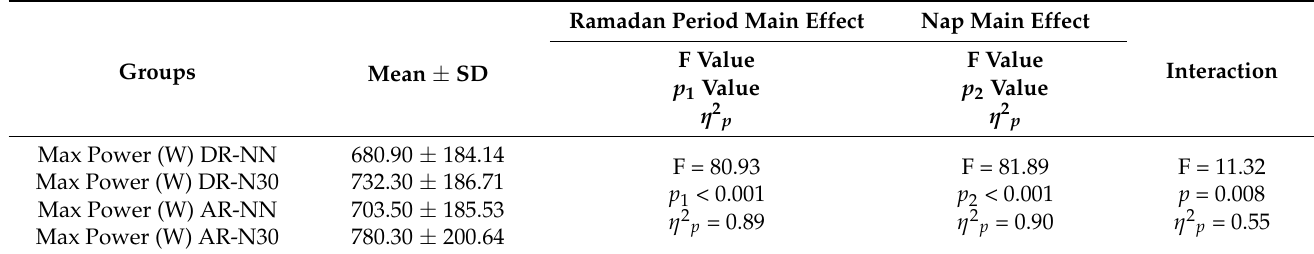
Table 1. Comparison of the measured values of the Max Power (W) (n = 10).